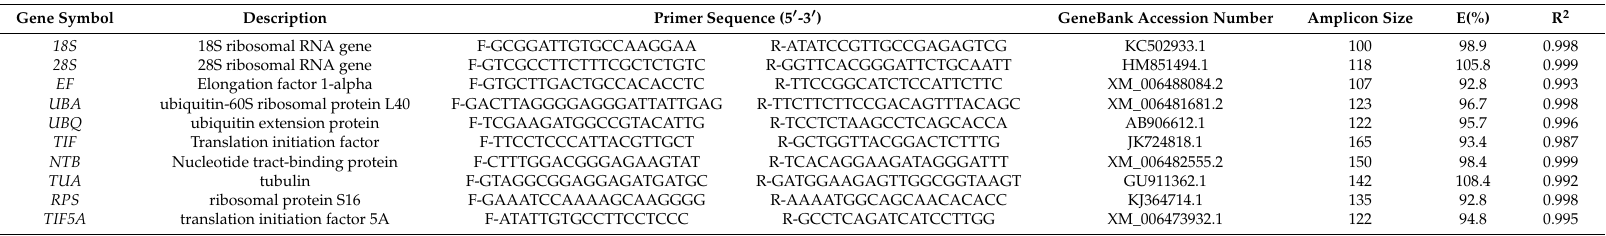
Table 1. Primer and related information for the 10 candidate reference genes 18S , 28S , EF , UBA , UBQ , TIF , NTB , TUA , RPS , and TIF5A for quantitative RT-PCR analysis in Zanthoxylum bungeanum